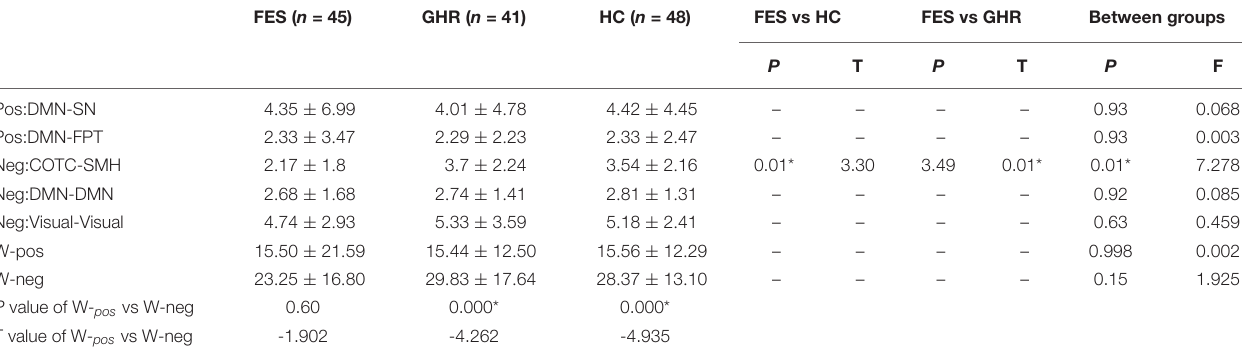
TABLE 2 | Comparison of network strength among the three groups [first episode schizophrenia (FES), genetic high-risk (GHR), and healthy controls (HCs)]. FES ( n = 45) GHR ( n = 41) HC ( n = 48) FES vs HC FES vs GHR Between groups P